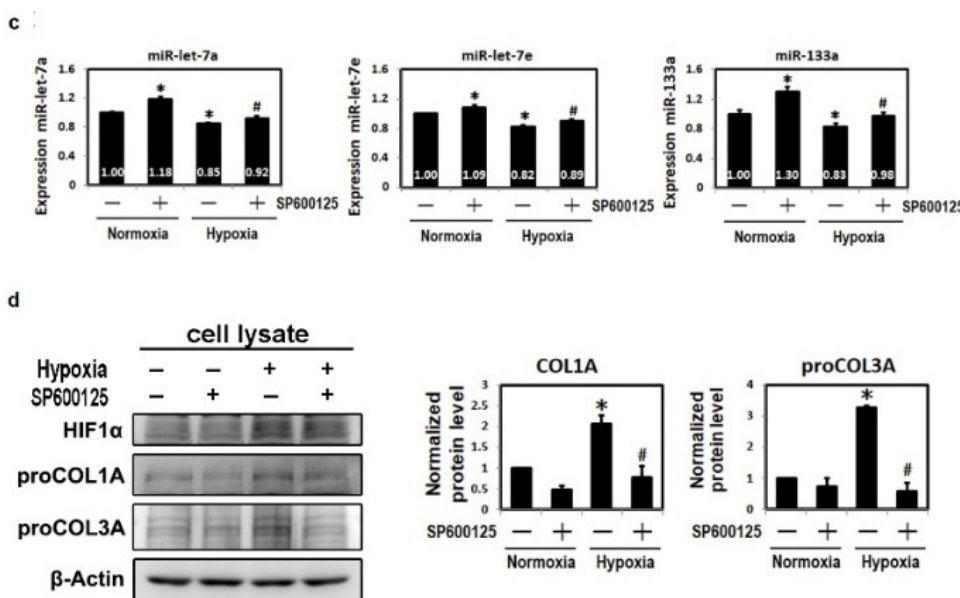
Figure 4. Post-translation repression of miR-let-7a, miR-let-7e and miR-133a by the JNK/SAPK pathway. ( a ) JNK pathway protein levels were evaluated by Western blotting and quantification ( b ) and HL-1 cells were treated with hypoxia. ( c ) Expressions of miR-133a, miR-let-7a and miR-let-7e were evaluated in HL-1 cells treated with SP600125 under hypoxic conditions. ( d ) Ex- pressions of COL1A and COL3A proteins were analyzed by Western blotting and quantification ( e ). Mean ± SD, n ≥ 3, * p < 0.05 vs. normoxia; # p < 0.05 vs. hypoxia.